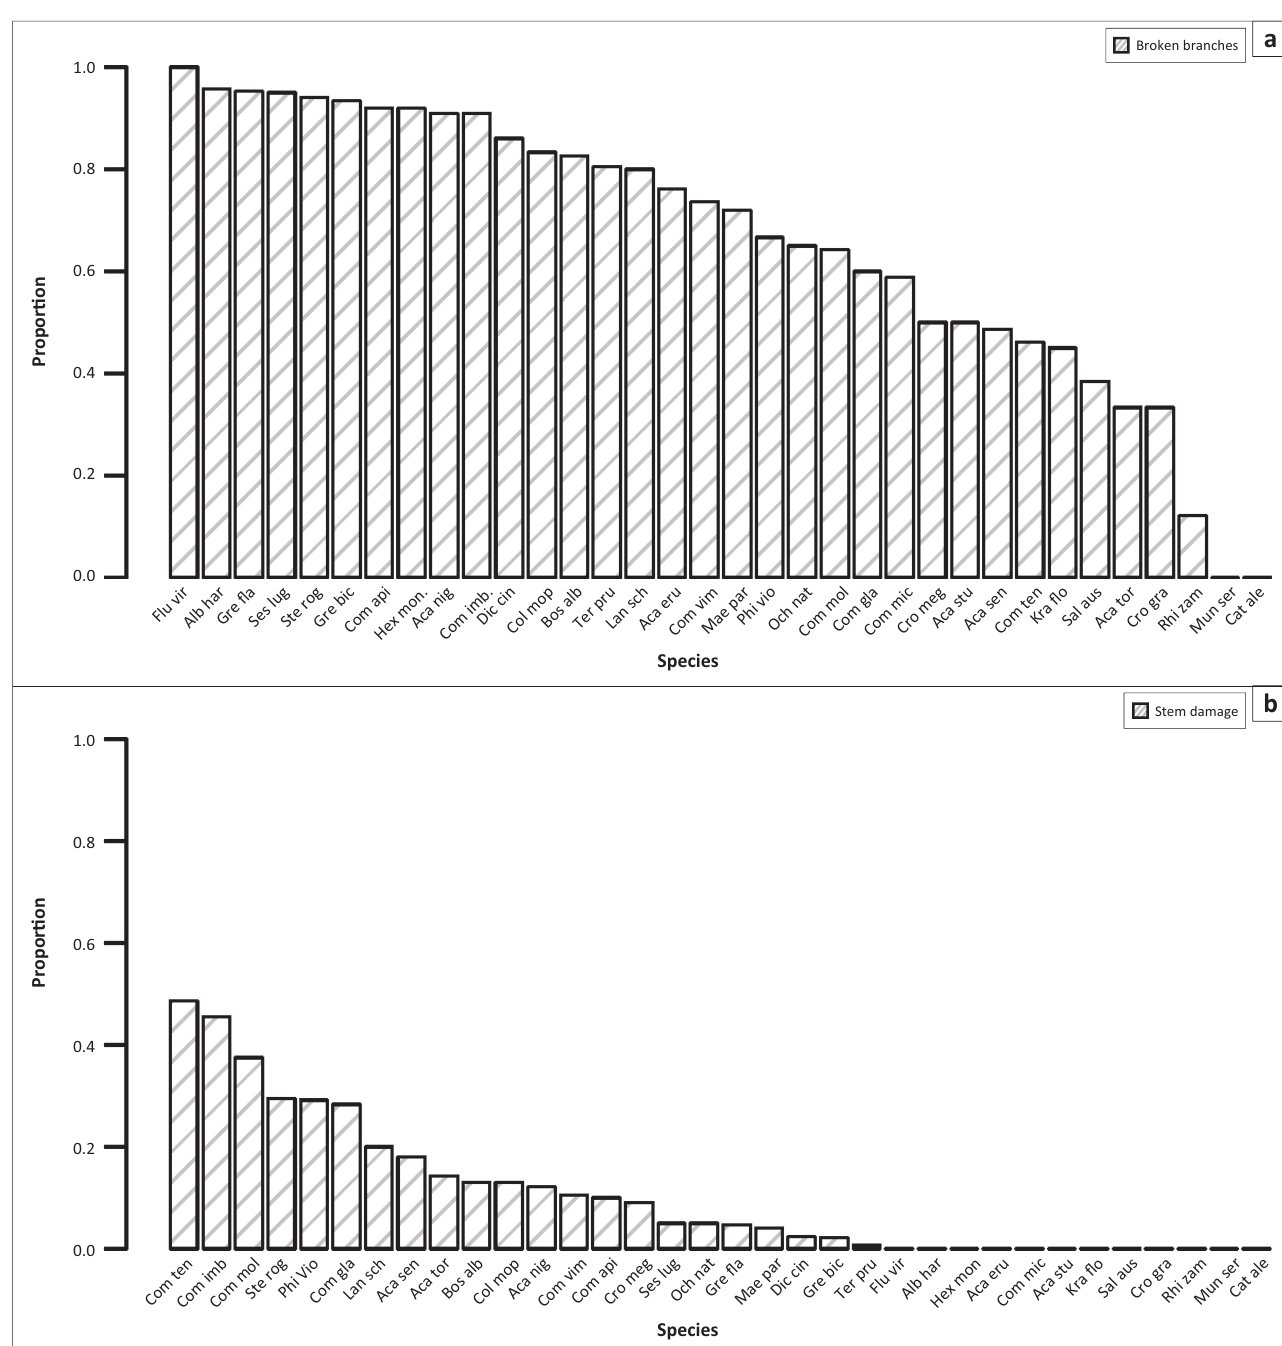
FIGURE 2: The proportion of each species with (a) broken branches and (b) stem